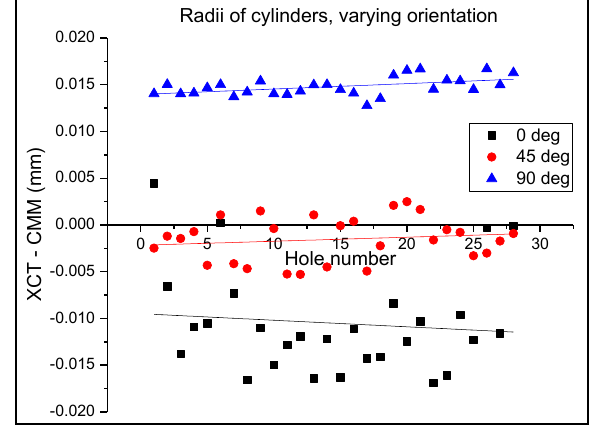
Figure 13: Deviation in cylinder radii at 1.6 times magnification using the cylinder fitted by Chebyshev fitting and